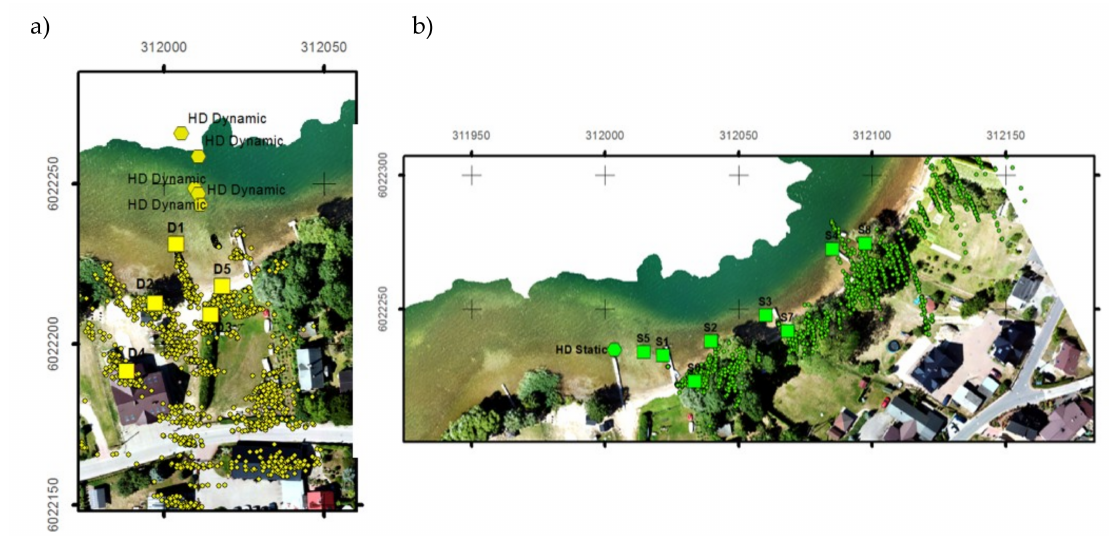
Figure 9. Radar image of analyzed scene for dynamic ( a ) and static ( b ) scenario. Analyzed objects are additionally marked and